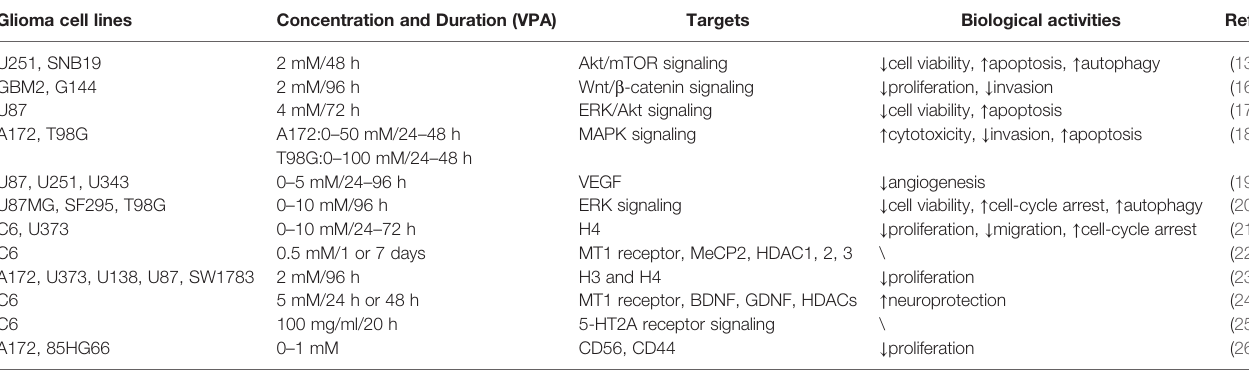
TABLE 1 | VPA was involved in cellular activities of glioma through signaling pathways and molecular targets. Glioma cell lines